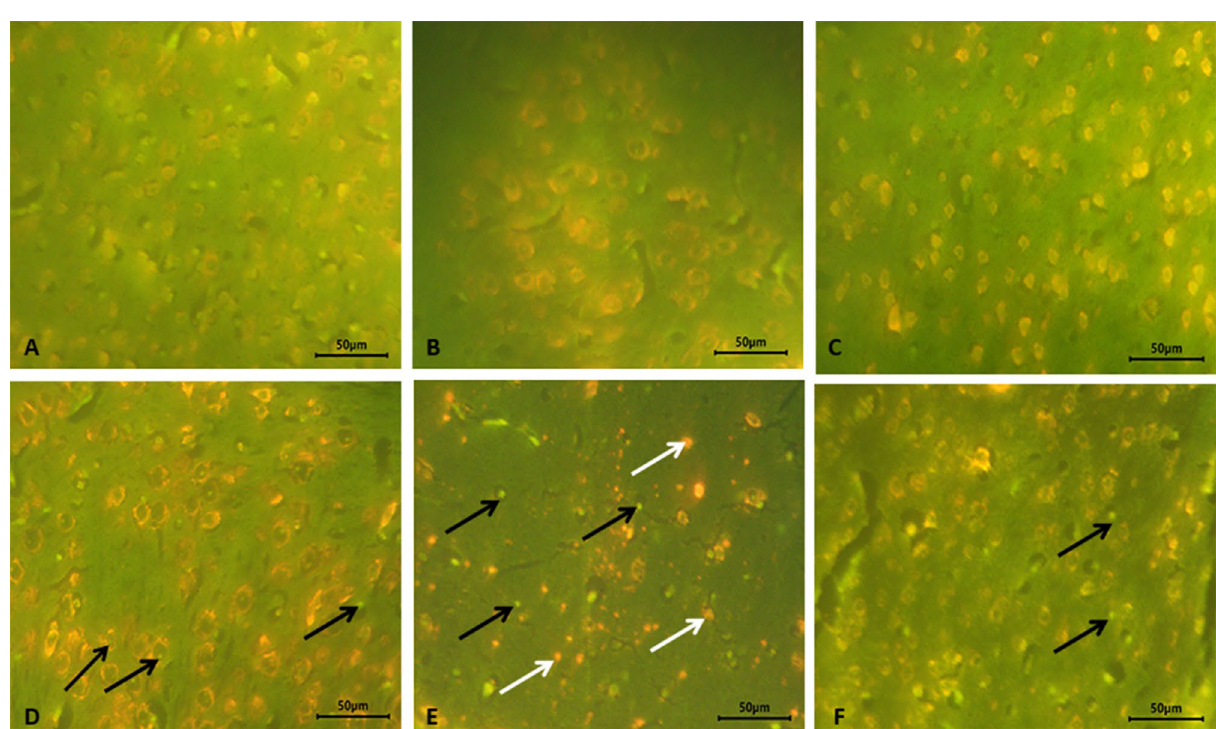
Figure 7. Representative micrograph of the control olive oil, blank nanoemulsion, and gum Arabic loaded nanoemulsion groups, respectively. Cells appear normal with a green nucleus ( A – C ). Early apoptotic cells with a bright green nucleus and condensed chromatin (black arrows), and late apoptotic cells with condensed orange chromatin (white arrows) present in bromobenzene group ( D , E ), A few early apoptotic cells (black arrows) in bromobenzene + gum Arabic loaded nanoemulsion group ( F ). Acridine orange